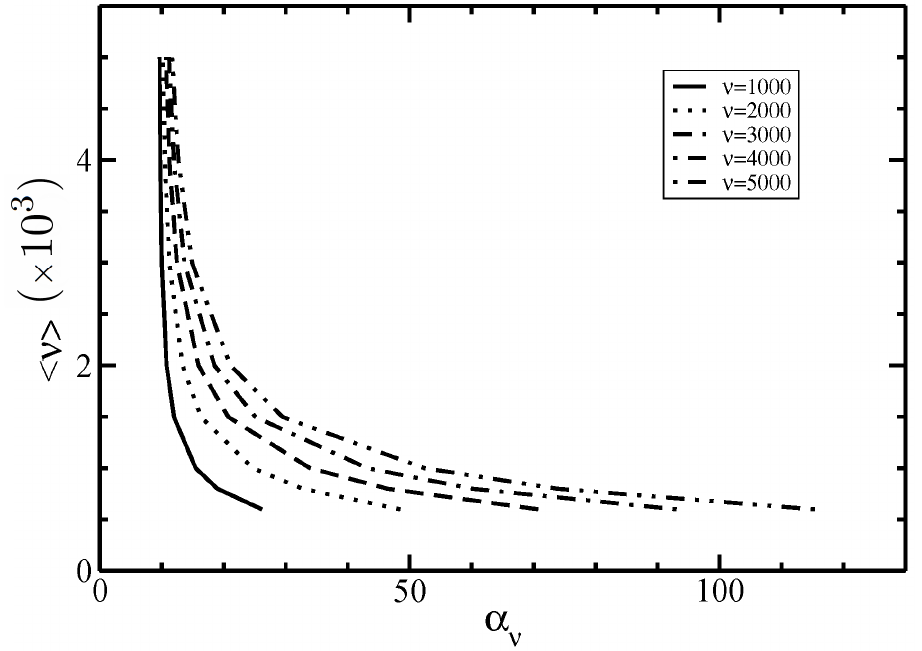
Figure 4. The Gaussian parameter α ν vs. the average size < ν > at I–N phase coexistence for different lengths of filaments ν .